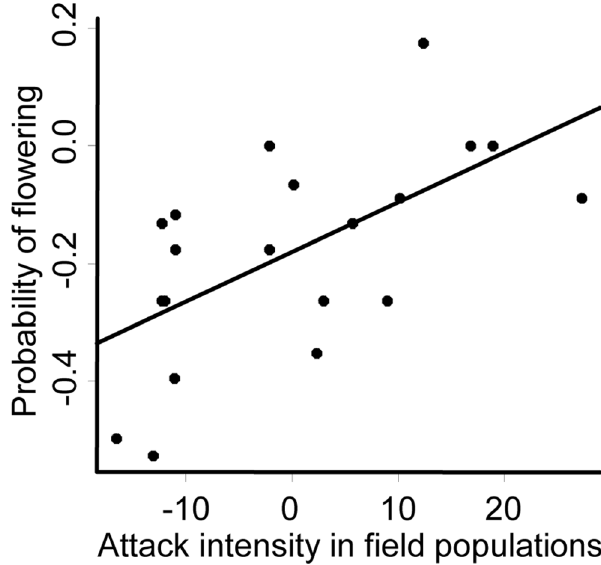
Figure 2. Relationship between tolerance and attack intensity in the field for Cardaminepratensis . Tolerance was estimated as the probability of flowering the year after herbivory. Attack intensity was measured as the percentage of oviposited plants in the field populations. Negative values correspond to relatively low attack intensity and positive values to relatively high attack intensity. Each symbol represents the mean values of one population. doi:10.1371/journal.pone.0099333.g002 PLOS ONE |